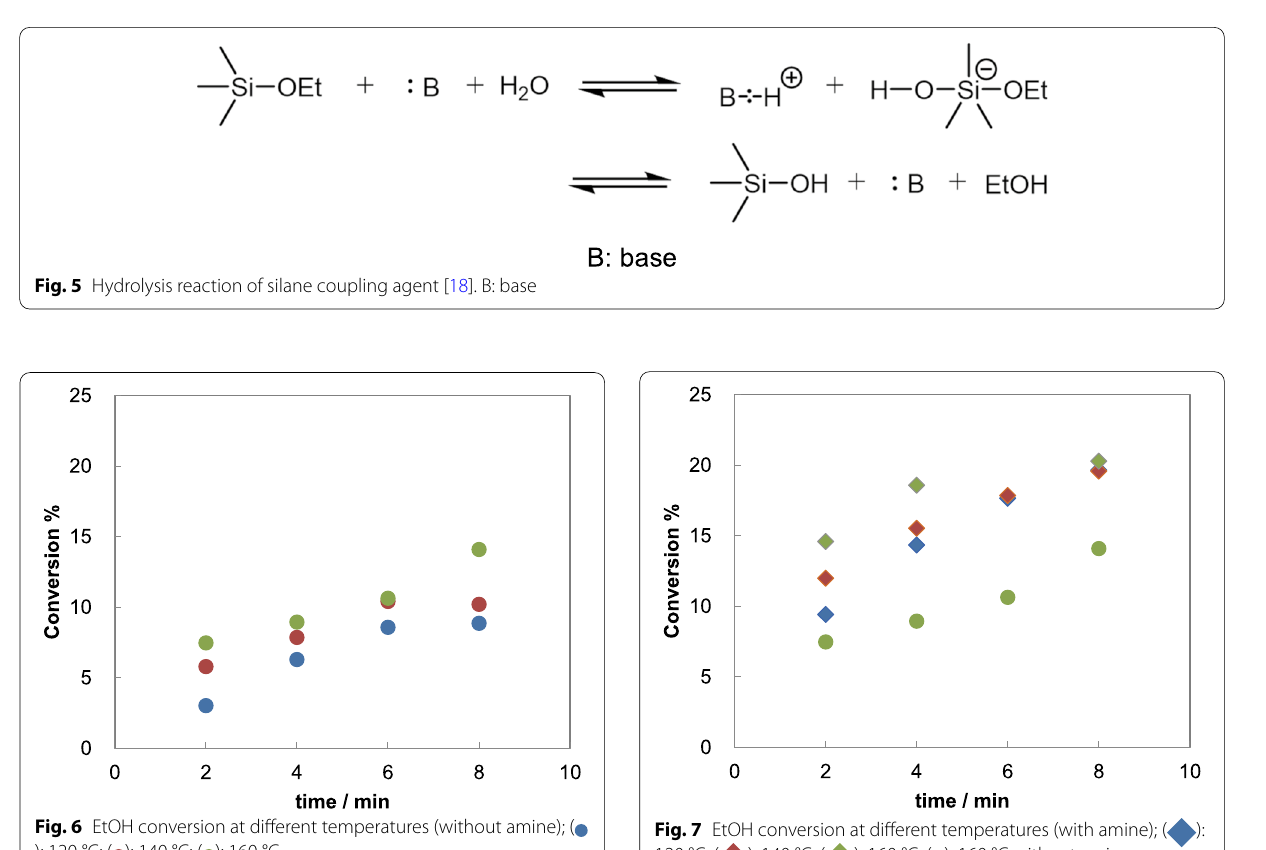
Fig. 7 EtOH conversion at different temperatures (with amine); ( ): 120 °C; ( ): 140 °C; ( ): 160 °C; ( ): 160 °C without